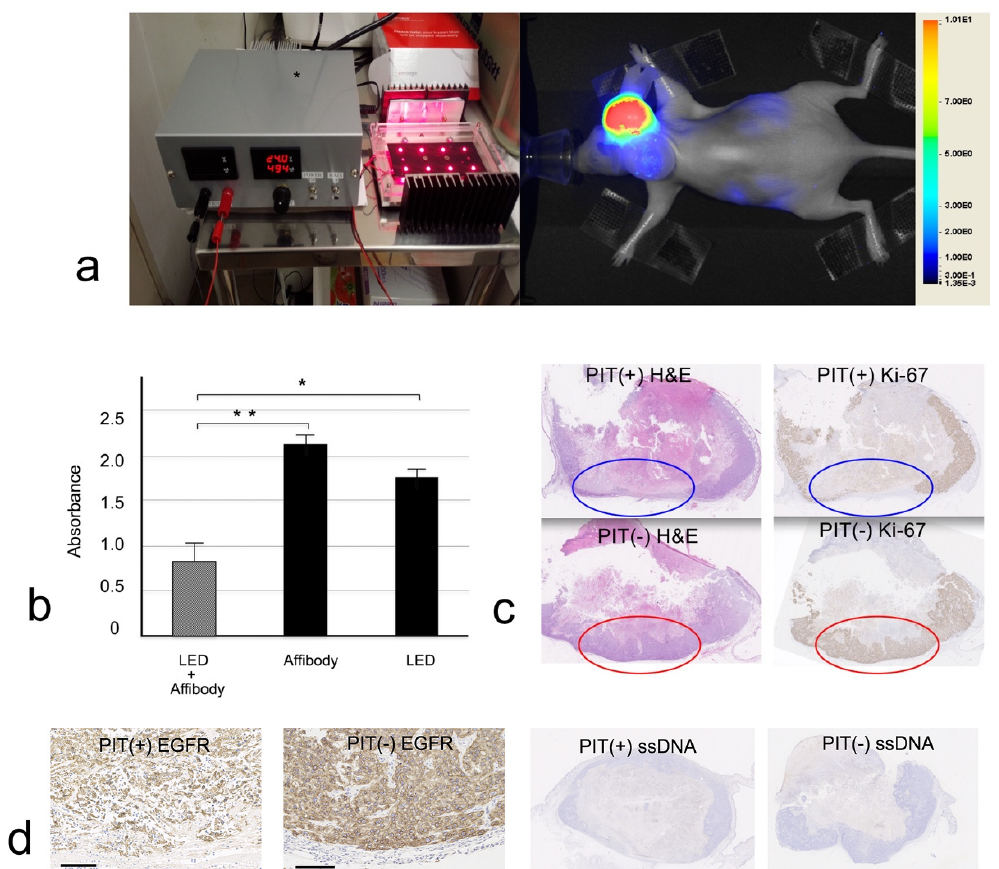
Figure 5. ( a ) Image of a custom-built illuminator (light emitting diode (LED) emission: peak wavelength, 690 nm). Image of SAS xenograft tumor in the back of a mouse after anti-EGFR affibody photoimmunotherapy (PIT). The image was captured one hour after the probe was injected into the right tumor. The contralateral xenograft tumor served as a control (right). ( b ) The CCK-8 assay showed that the combination of the EGFR affibody IR700 probe and NIR irradiation decreased the survival rate of SAS cells rather than exposure to NIR or the EGFR affibody IR700 probe alone ( p < 0.0001). LED, NIR irradiation ( c ) decreased proliferation in the bottom region of an SAS xenograft tumor treated with PIT, as determined by immunohistochemical staining for Ki-67 (top row), compared to that in a nontreated xenograft tumor (bottom row) (panoramic digital-image source lens, × 40). Circles show the bottom region of tumors (blue = PIT-treated, red = PIT-untreated). ( d ) Immunohistochemical staining for EGFR was performed. Tumor cells were necrotic in the bottom region of the PIT-treated tumors. In the corresponding region of PIT-untreated tumor, EGFR-expressing tumor cells were proliferating. ssDNA immunohistochemistry, which was used for assessing apoptosis, showed negative staining in both PIT-treated and PIT-untreated tumors (panoramic digital-image source lens, ×40, scale bar: 100 μ m).